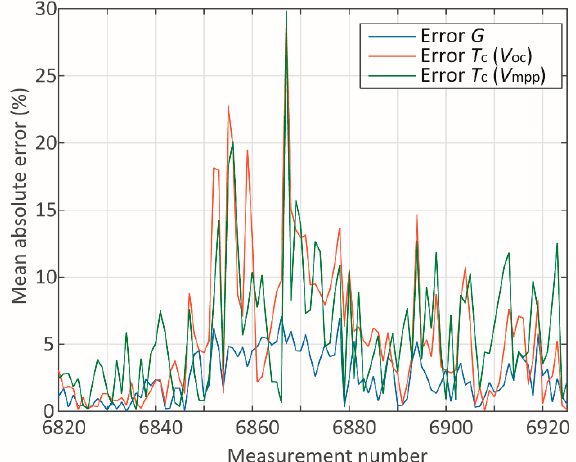
Figure 10. Absolute errors during cloudy days.